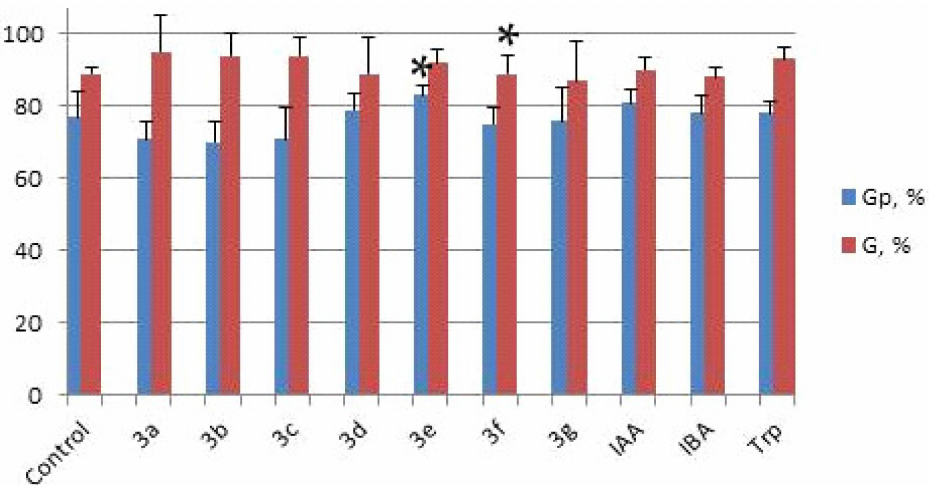
Figure 1. Germination potential and germination of tested compounds. *—traditional designations for statistically significant results. Table 2. The relative water content of wheat shoots treated with compounds 3 under water stress. Hours After the